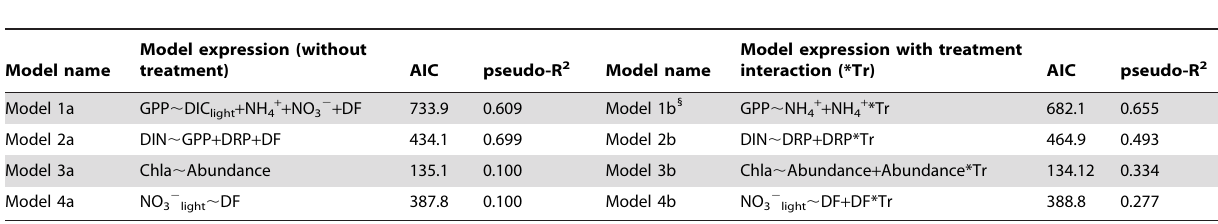
Table 1. The most parsimonious Generalized Linear Models (GLMs) relating different environmental and macrofauna community variables with and without treatment as a factor (terms that were not significant were dropped from the final